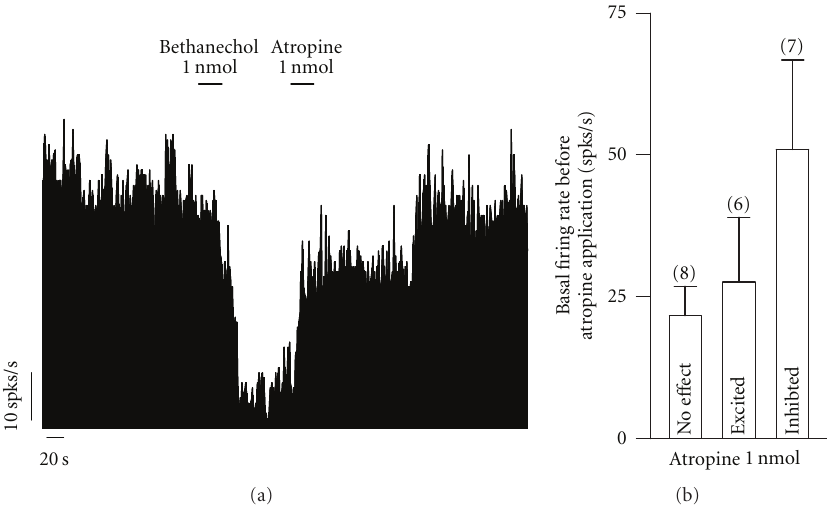
Figure 3: The heterogeneous e ff ects in the spiking rate of globus pallidus neurons evoked by local blockade of MRs do not depend on the firing rate before application of atropine. (a) Frequency histogram of a pallidal neuron showing the blockade of the inhibition evoked by activation of MRs by atropine. spks/s, spikes per second. (b) Statistics illustrating that the e ff ect of the local blockade of MRs in the spiking rate does not depend on the baseline firing rate before local infusion of 1 nmol atropine.